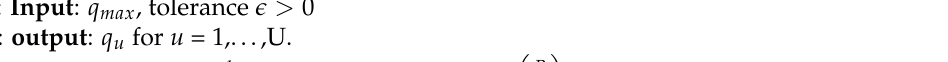
Algorithm 3 Bisection algorithm for solving the max-min fairness power allocation prob- lem.